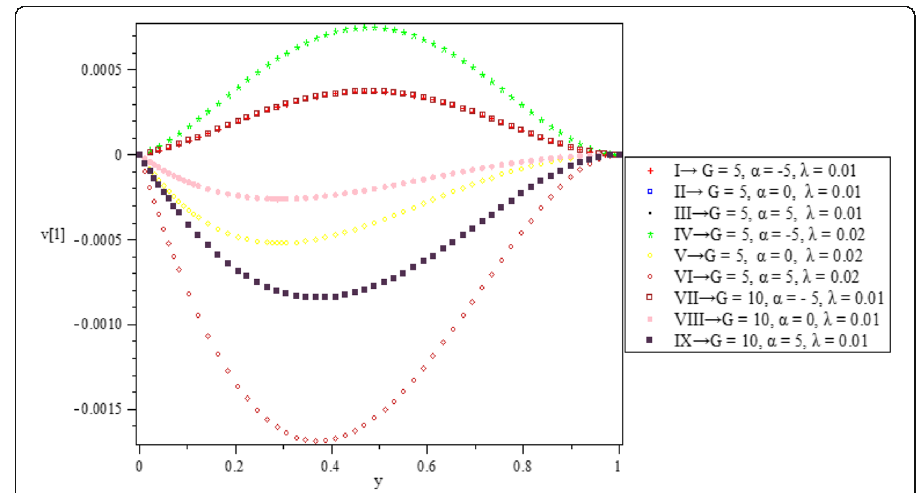
Fig. 21 First-order velocity (v[1] profile, r = − 1, ϵ = 0.25, P = 0.71, and β = 0)